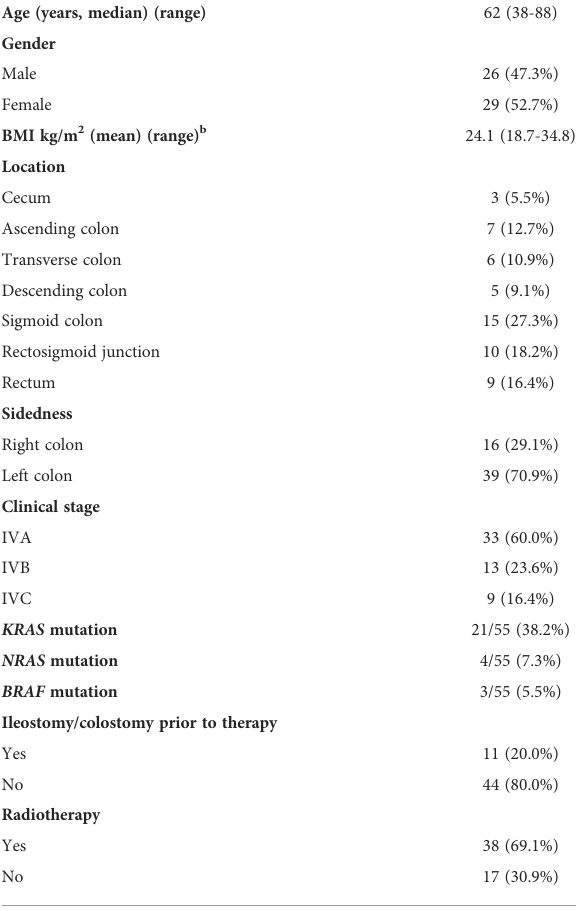
TABLE 1 Patient Characteristics at Diagnosis and Gene Variation Pro fi les (n = 55).